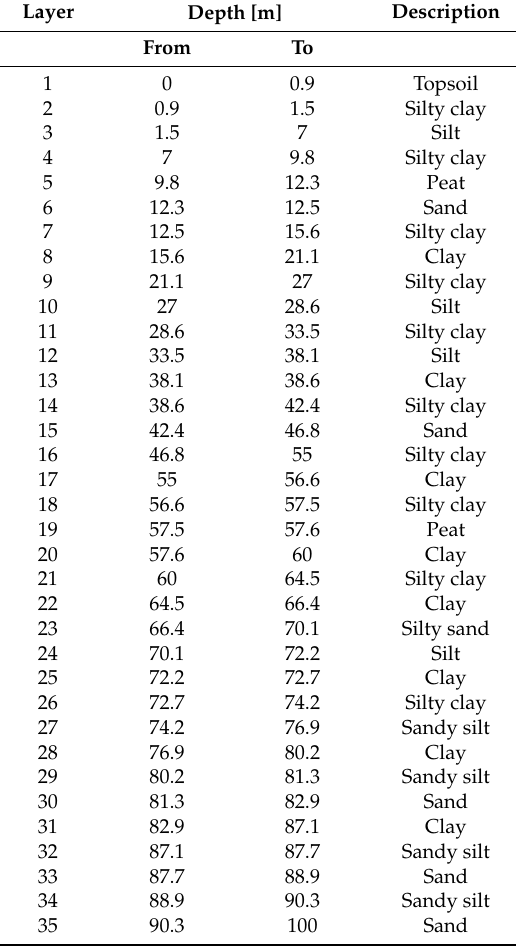
Table 5. The simplified composition of the